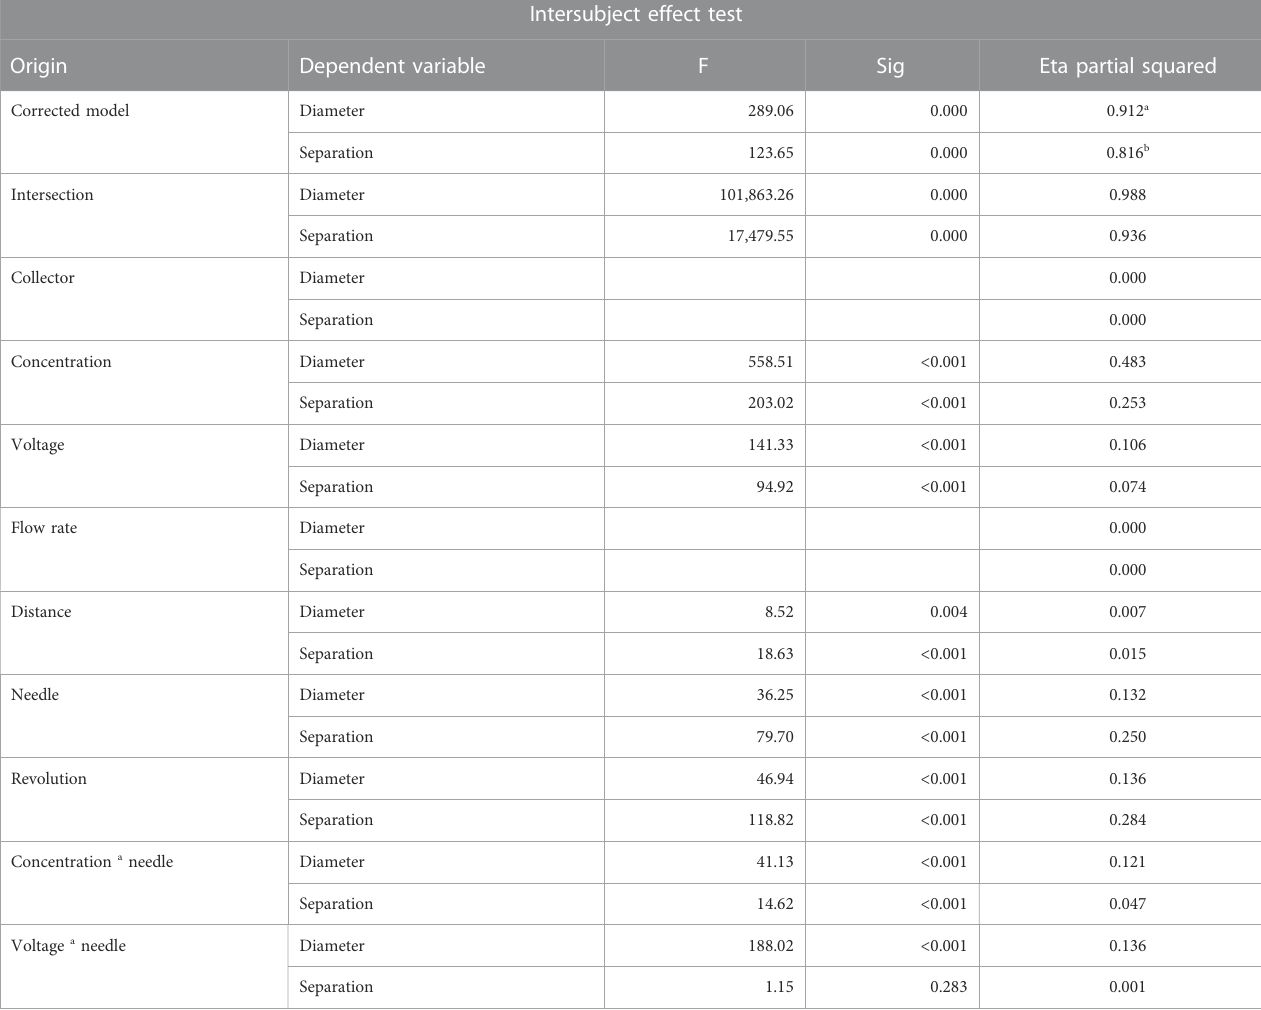
TABLE 3 MANOVA for the diameter of the fi bres and inter- fi bre separation.